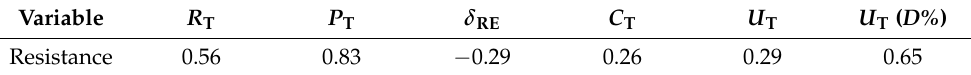
Figure 8. Comparison of wave elevation at y/L = 0.172 longitudinal section obtained by computation and experiment for intact ship.